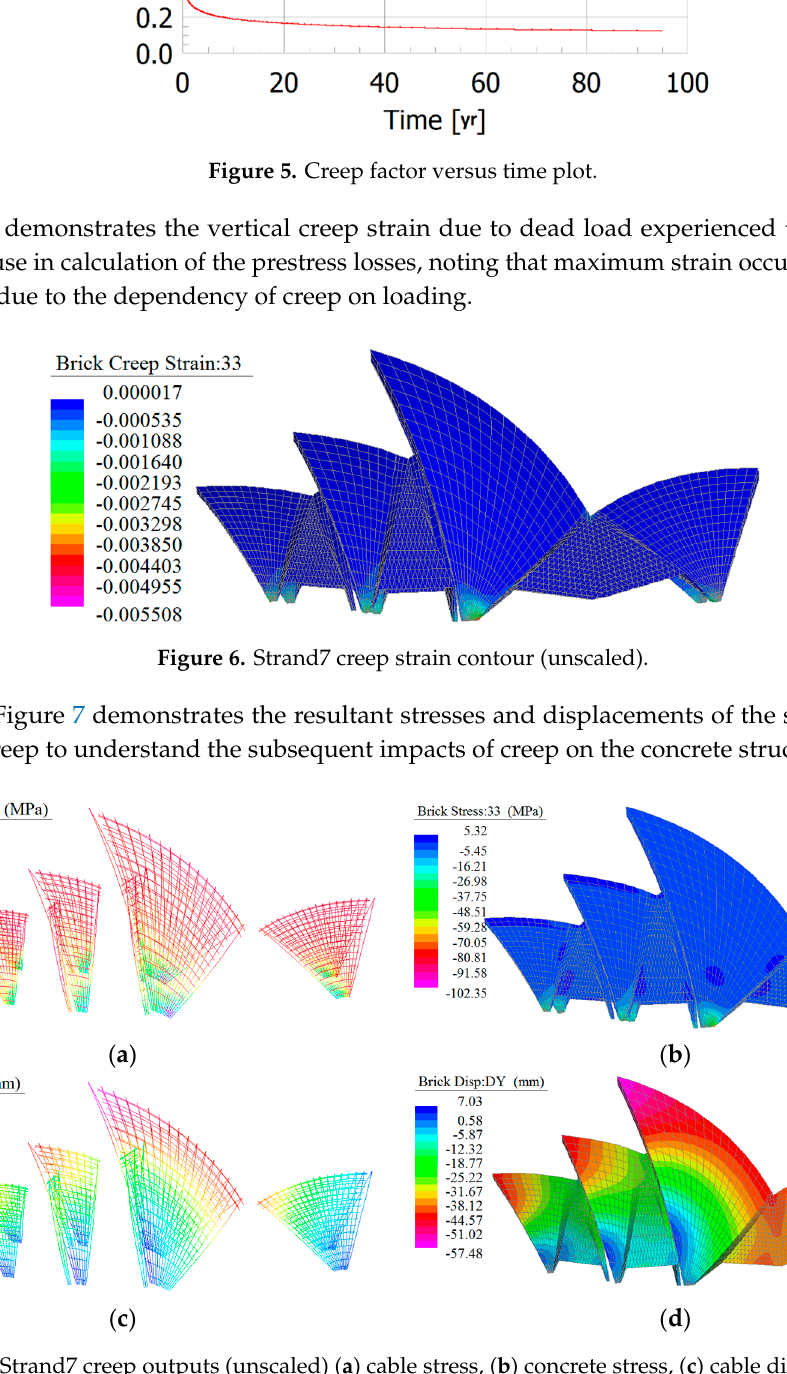
Figure 7. Strand7 creep outputs (unscaled) ( a ) cable stress, ( b ) concrete stress, ( c ) cable displacement, ( d ) concrete displacement.